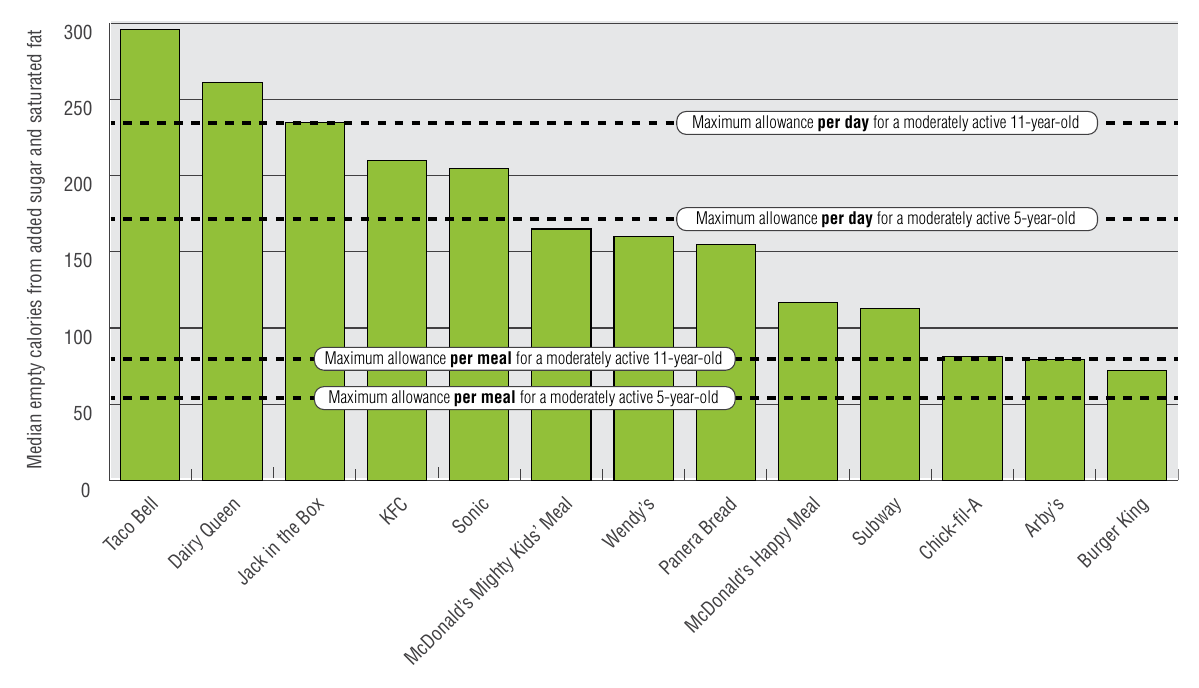
Figure 19. Empty calories in kids’ meal